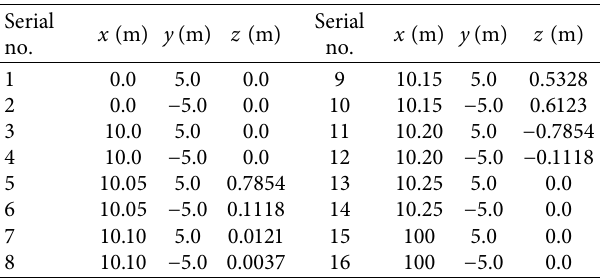
Figure 6: Dynamic model of high-speed tracked vehicle action system. Table 4: List of simulated pavement